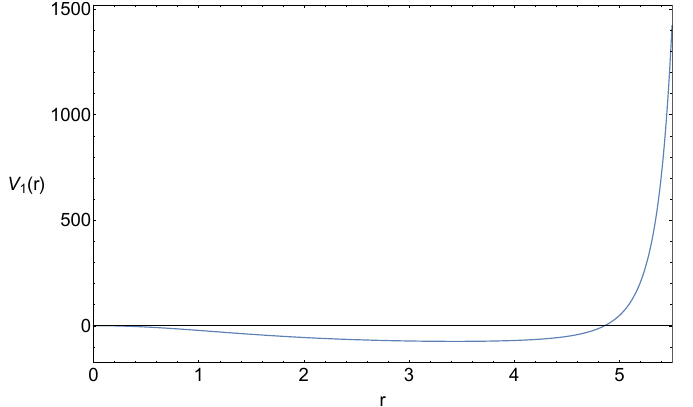
Figure 2. Plot of the potential V 1 ( r ) versus r for φ 0 = 1, b = 2.5, a = 0.001, λ = 0.00001, C 2 = 0.1, V 0 = 100 and A 0 = −